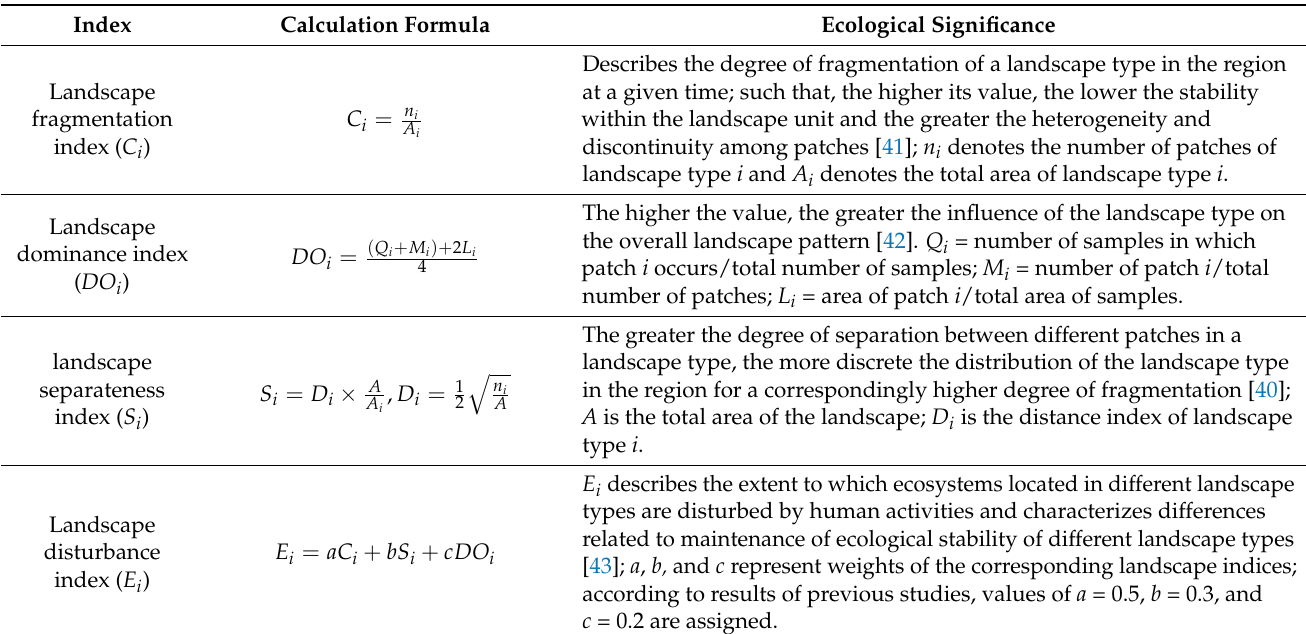
Table 1. Calculation formula of landscape index and ecological